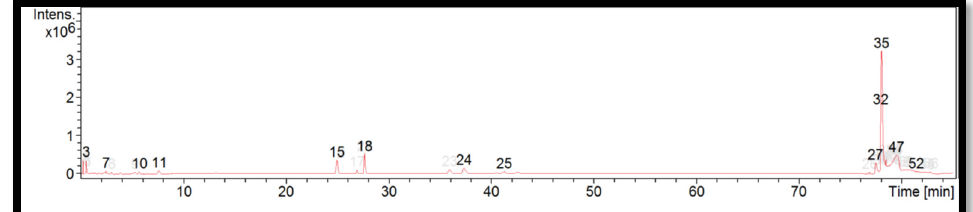
Figure 6. LC-MS/MS chromatogram of S. brachycladum . Table 10. The compounds identified in S. brachycladum .